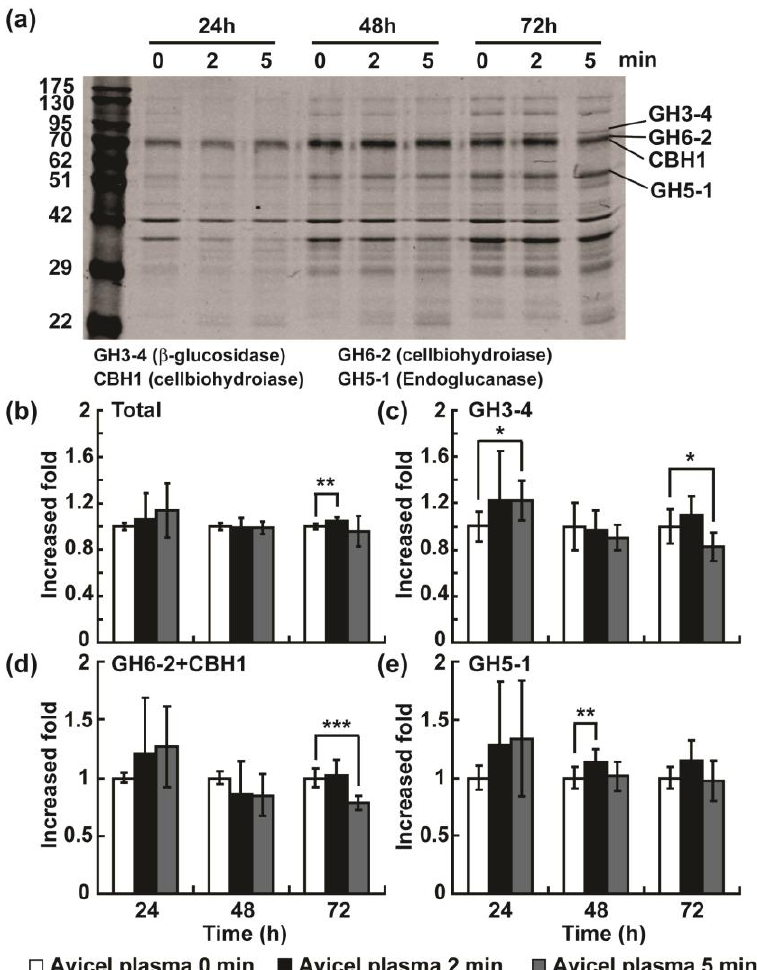
Figure 3. Analysis of cellulolytic enzymes in Avicel media by gel electrophoresis. The media was harvested at 24, 48, and 72 h after plasma treatment (0, 2, and 5 min). ( a ) Secreted proteins into media resolved on an SDS-PAGE gel. ( b – e ) The relative intensity of all 4 enzyme bands ( b ) and each protein band, namely ( c ) GH3-4, ( d ) GH6-2 + CBH1, and ( e ) GH5-1. ImageJ software (National Institute of Health, Bethesda, MD, USA) was used for quantifying the relative band intensities from the plasma-treated group compared to those from the untreated group. Each value represents the mean of six replicate measurements: * p < 0.05, ** p < 0.01, *** p <